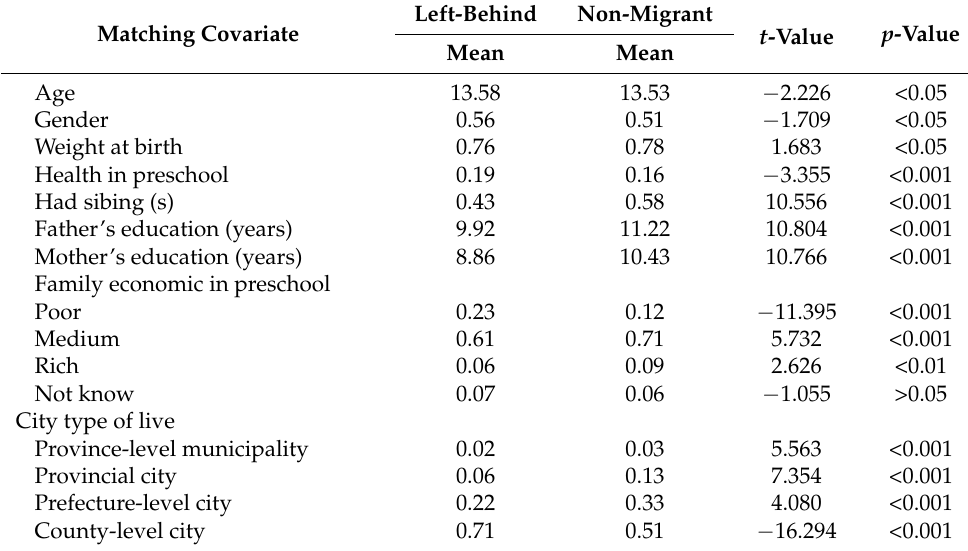
Table A3. The t -test of the matching variables in the analytical sample of urban children (N = 7527). Matching Covariate